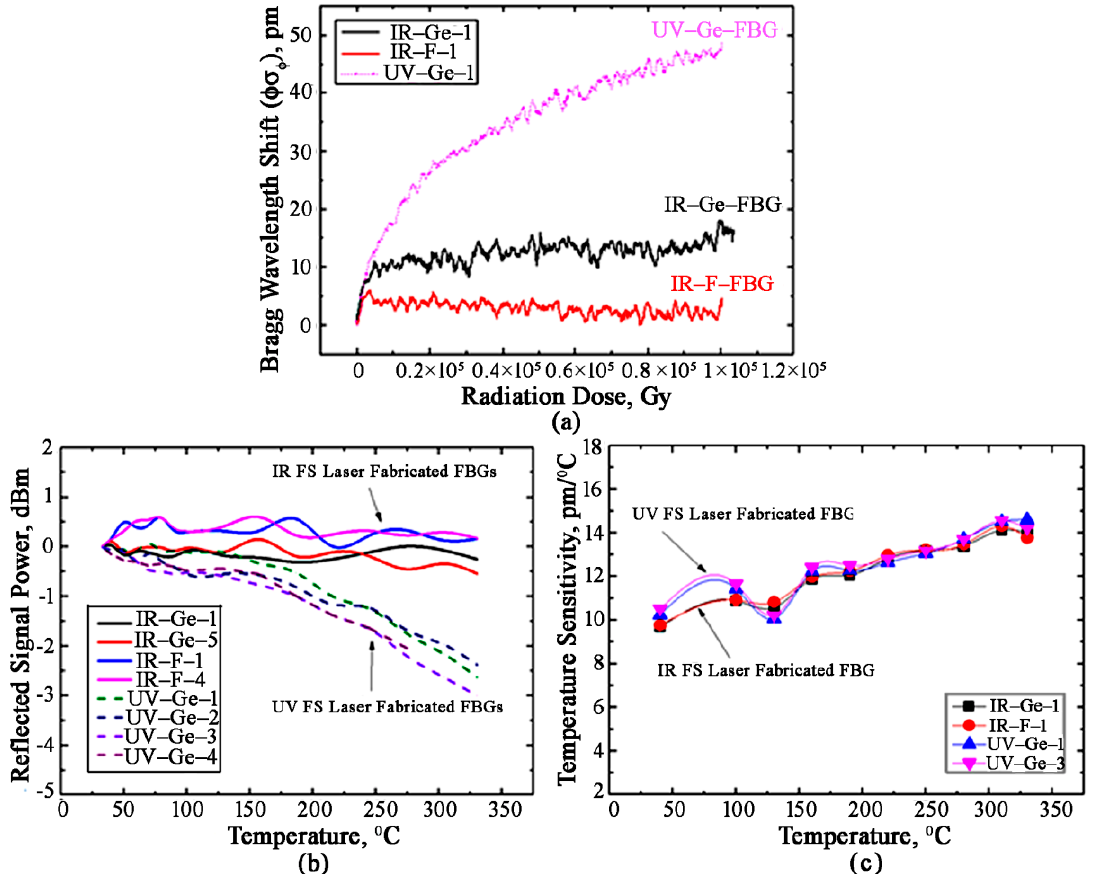
Figure 10. Radiation resistence, temperature sensitivity, and impact of temperature on the reflected signal power of different kinds of F/Ge-doped FBG sensors fabricated by IR and UV femtosecond lasers. ( a ) Bragg wavelength shift under Gamma radiation; ( b ) impact of temperature on the power of the reflected signal at the Bragg wavelength; ( c ) temperature sensitivity.